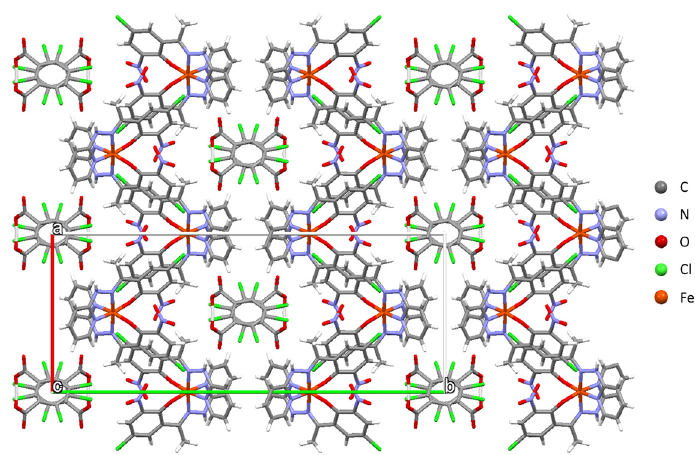
Figure 2. View of the crystal structure of 1-Cl along the c-axis. Table 1. Crystallographic data of 1-Cl , 1-Br , 2-Cl , and 2-Br . Crystallographic Data